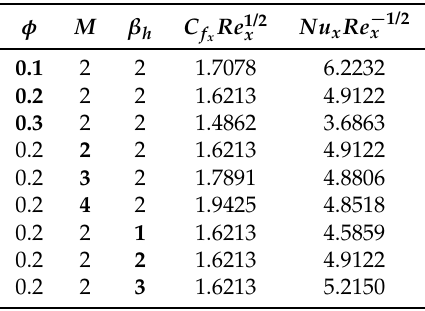
Re 1/2 x and Nu x Re − 1/2 x for different parameter values when Pr = Table 2. Variations in C f X